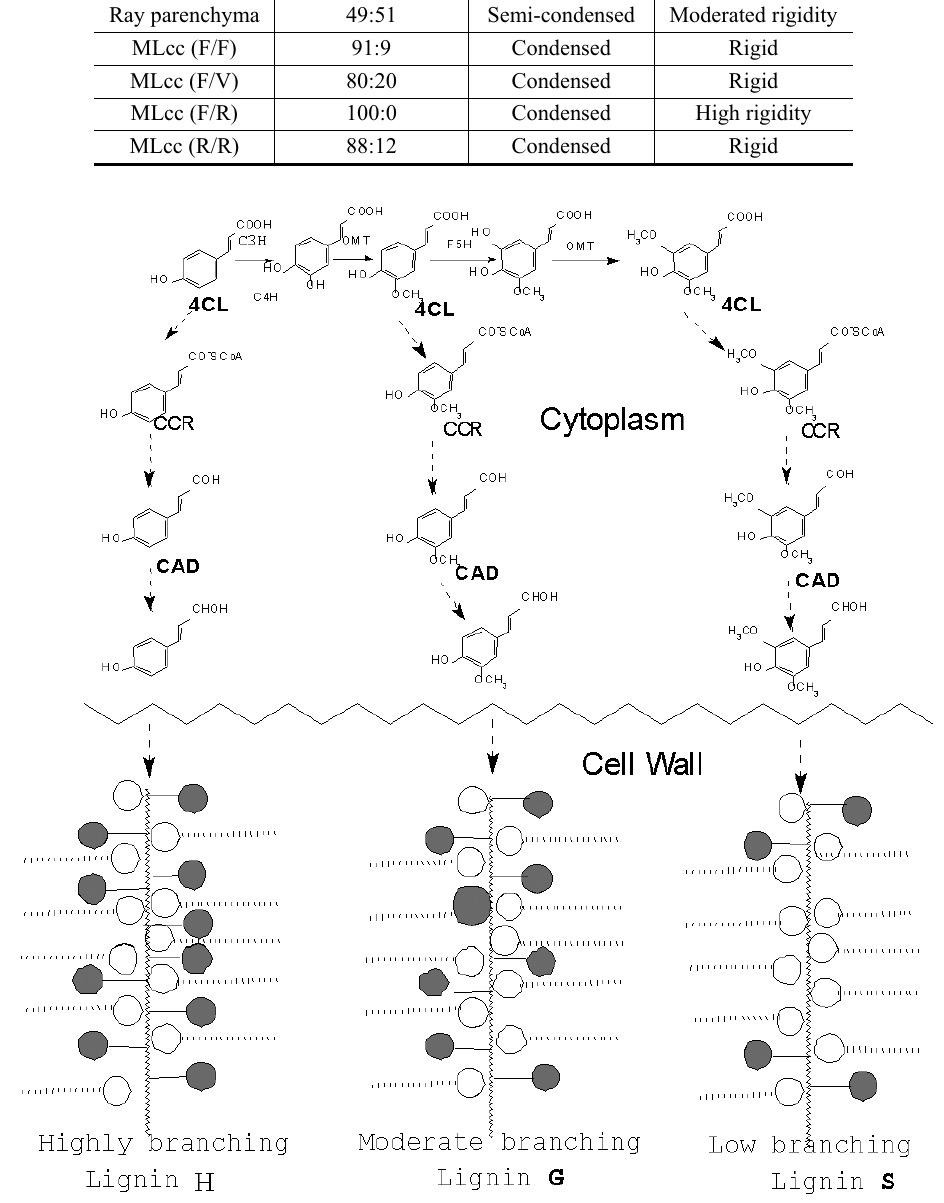
Fig. 1 – Syringyl and Guaiacyl lignins biosynthesis (pre-polymerization). PAL -Phenylalanine Amonia-lyase, C3H -4-Hydroxycinnamate-3-hydroxylase, 5H -Ferulate-5-hydroxylase, OMT -5-Adenosyl-methyonine:caffeate/5- Hydroxyferulate-O-ethyltransferase, 4CL -Hydroxycinnamoyl:CoA ligase, CCR -Hydroxycinnamyl:CoA reductase, CAD -Cinnamyl alcohol dehydrogenase, C4H -Cinnamate-4-hydroxylase